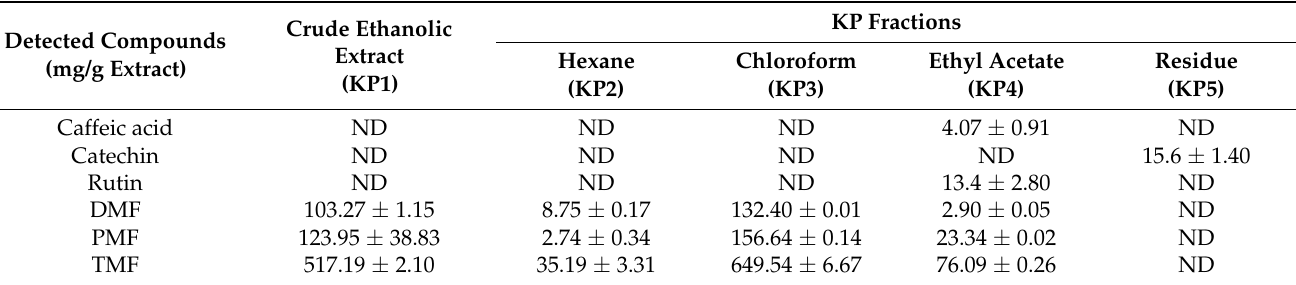
Table 1. Quantification of phytochemicals, DMF, PMF, and TMF contents in K. parviflora crude extract and its fractions.